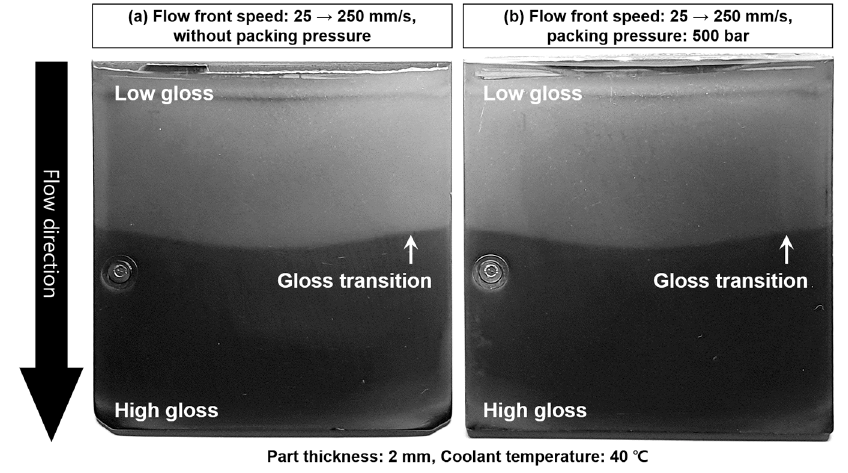
Figure 15. Effect of the packing pressure on the gloss transition defect caused by the flow fluctuation 25–250 mm / s; ( a ) without packing pressure, and ( b ) with 500 bar of packing pressure.